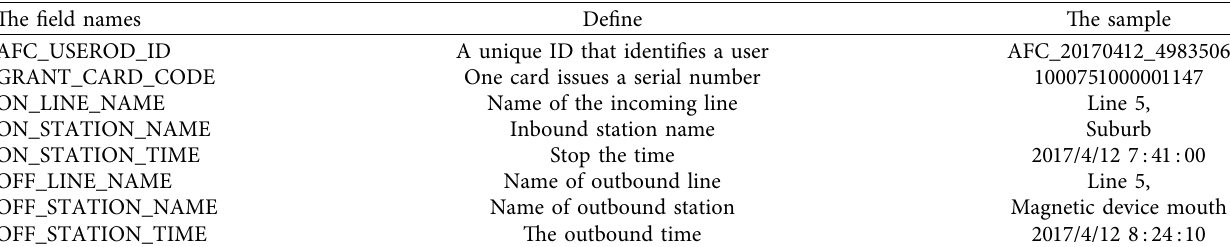
Figure 4: 2017 Beijing metro network diagram. Table 4: Commonly used key felds in AFC